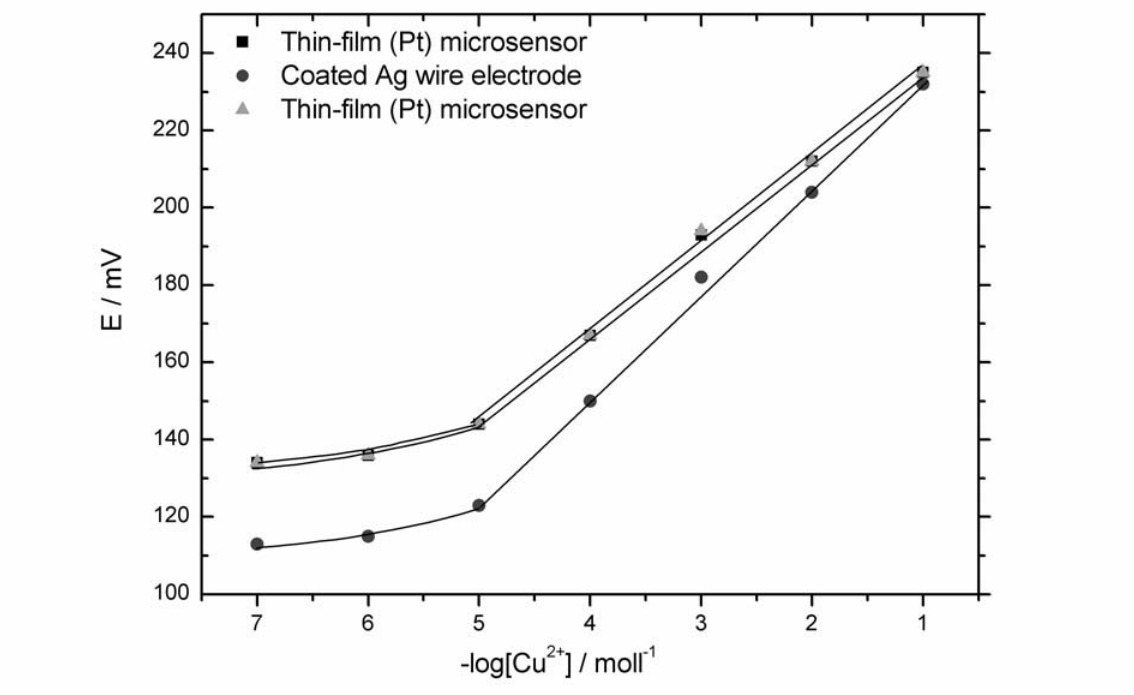
Figure 3. Potentiometric calibration graph of the Cu(II) thin-film microsensors based on PVC